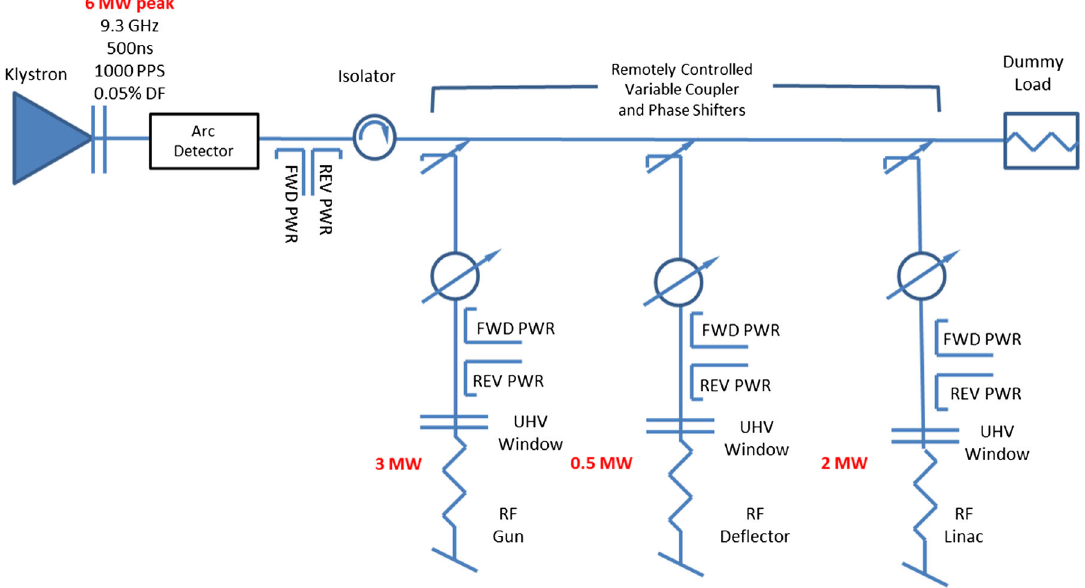
FIG. 23. Layout of rf waveguide equipment. Power is divided from the single klystron into three arms for the photoinjector, linac, and deflector cavity. The phase and amplitude in each arm is individually controlled allowing flexibility in the power